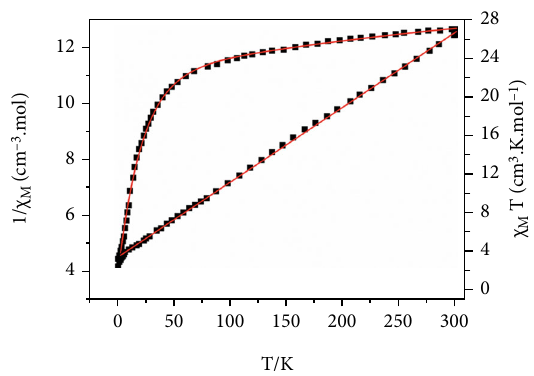
− 1 for 1 at one T and χ M M